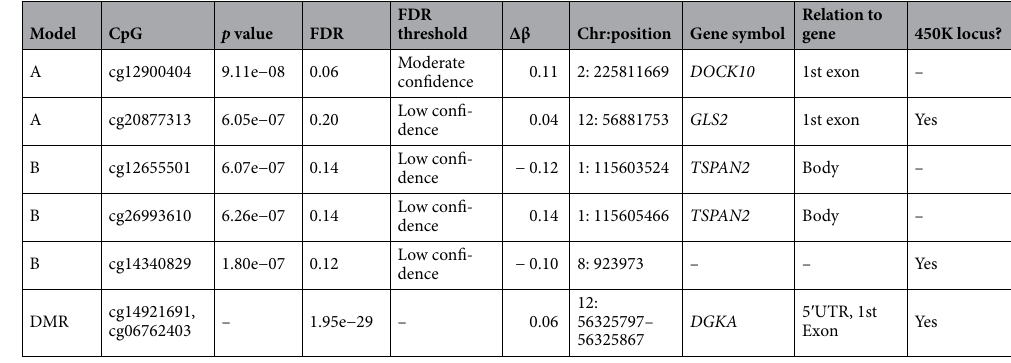
Table 3. Top CpGs with differential DNAme by SSRI-exposure status. Linear modelling p value and false discovery rates (FDR) shown, Δβ is difference in DNAme calculated as Δβ = β SSRI-exposed – β SSRI non-exposed . hg19 chromosome (Chr) and coordinates (Position) for each CpG are indicated, as are genes that each CpG overlaps, and whether each CpG is covered by a probe on the 450K DNA methylation array. A and B in the Model Column refer to model A and model B, DMR refers to the differentially-methylated region analysis.